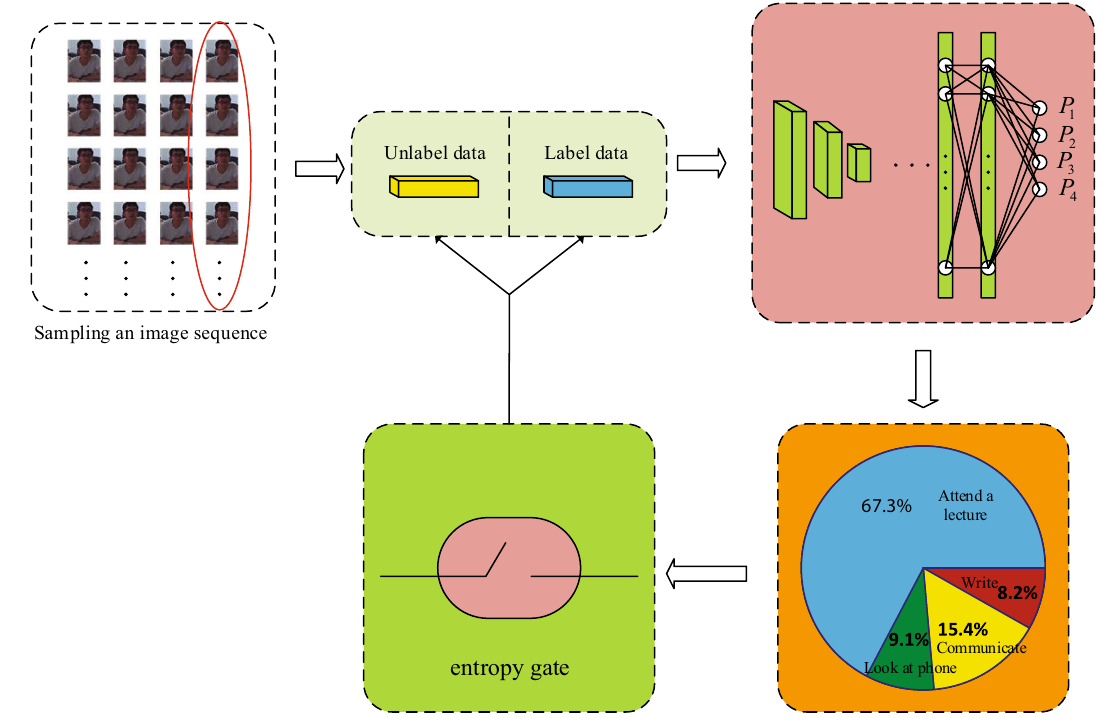
Fig. 2 The proposed